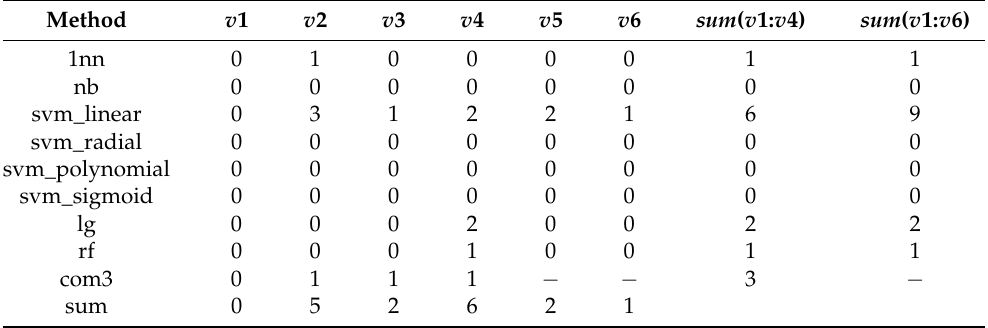
Table 14. Best results for THRESHOLD 0.7 : We counted the number of times the sensitivity thresh- old of 0.7 was exceeded. We considered variants v1 to v6. The best method was found to be svm_linear and com3 and variants v4 and v2. Slightly better were v4 and svm_linear. It is worth noting that com3 also includes svm_linear. In yellow, we highlighted the best methods and